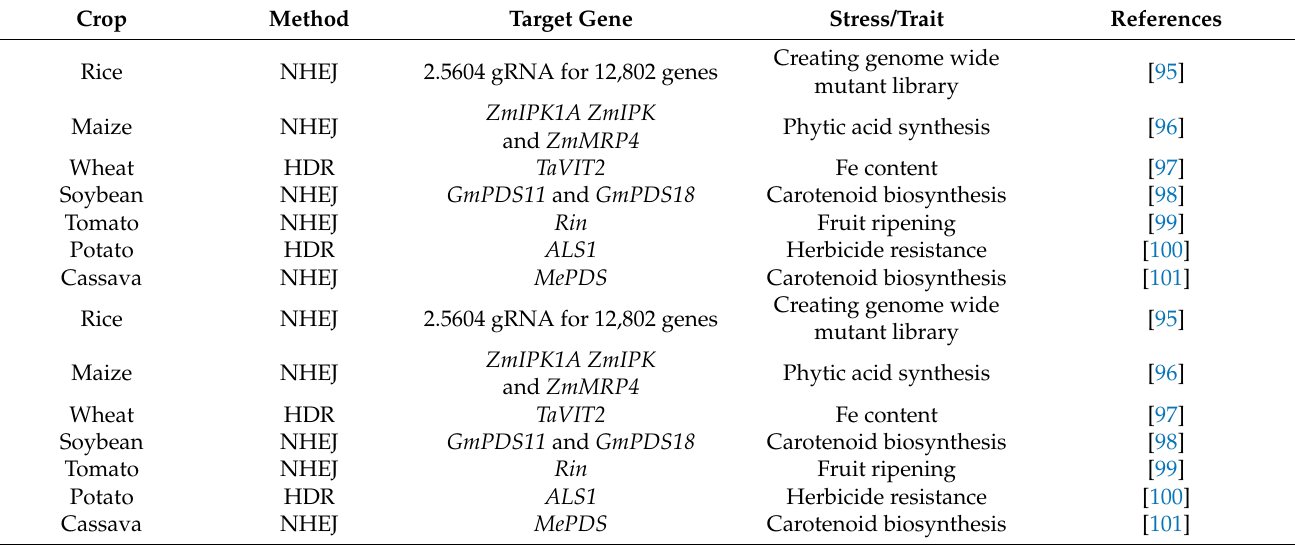
Table 8. Application of CRISPR-Cas9 technology in plants for nutritional